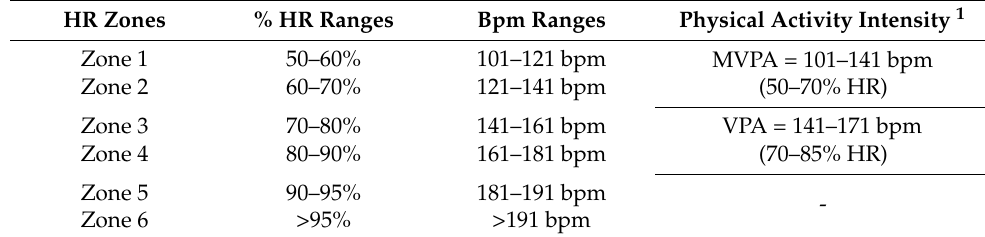
Table 1. Reference ranges of the HR max